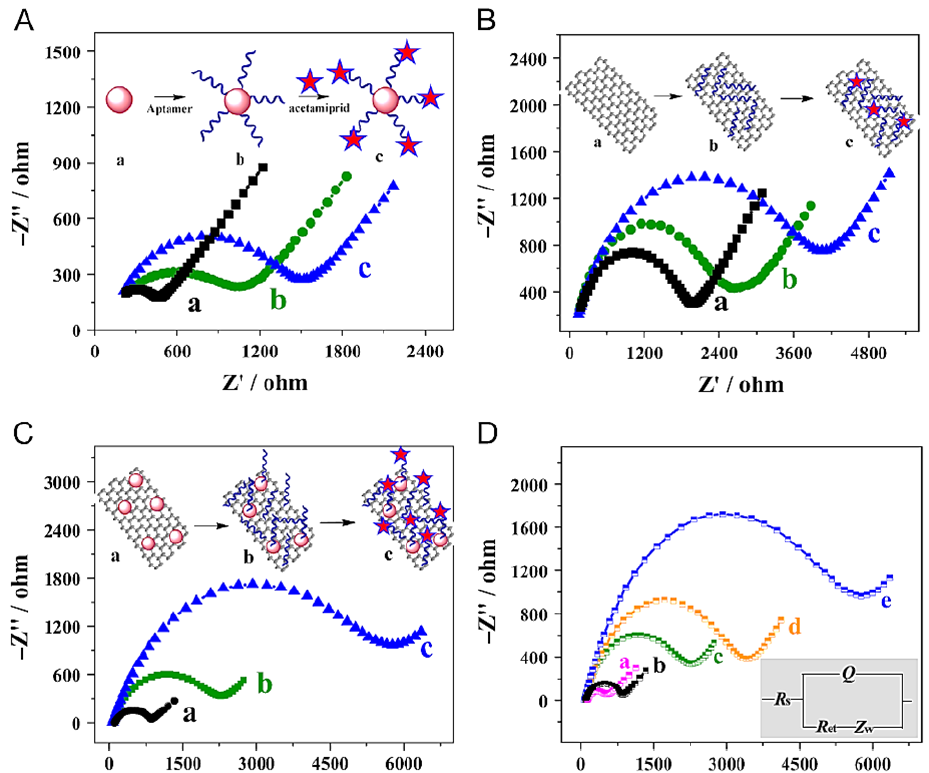
Figure 4. Comparison of the EIS responses for the GCE modified with different nanomaterials before and after aptamer immobilization and acetamiprid detection: ( A ) AuNPs/GCE, ( B ) MWCNT-rGONR/GCE, ( C ) Au/MWCNT-rGONR/GCE; ( D ) EIS responses of bare GCE (a), Au/MWCNT-rGONR/GCE (b), aptamer/Au/MWCNT-rGONR/GCE (c), MCH/aptamer/Au/MWCNT-rGONR/GCE (d) in 0.1 M PBS (pH 7.0) containing 5 mM [Fe(CN) 6 ] 3 − /4 − and 0.1 M KNO 3 , and EIS responses of MCH/aptamer/Au/MWCNT-rGONR/GCE (e) after 100 nM acetamiprid captured on the modified electrode in 0.1 M PBS (pH 7.0) containing 5 mM [Fe(CN) 6 ] 3 − /4 − and 0.1 M KNO 3 . Reprinted from [145].